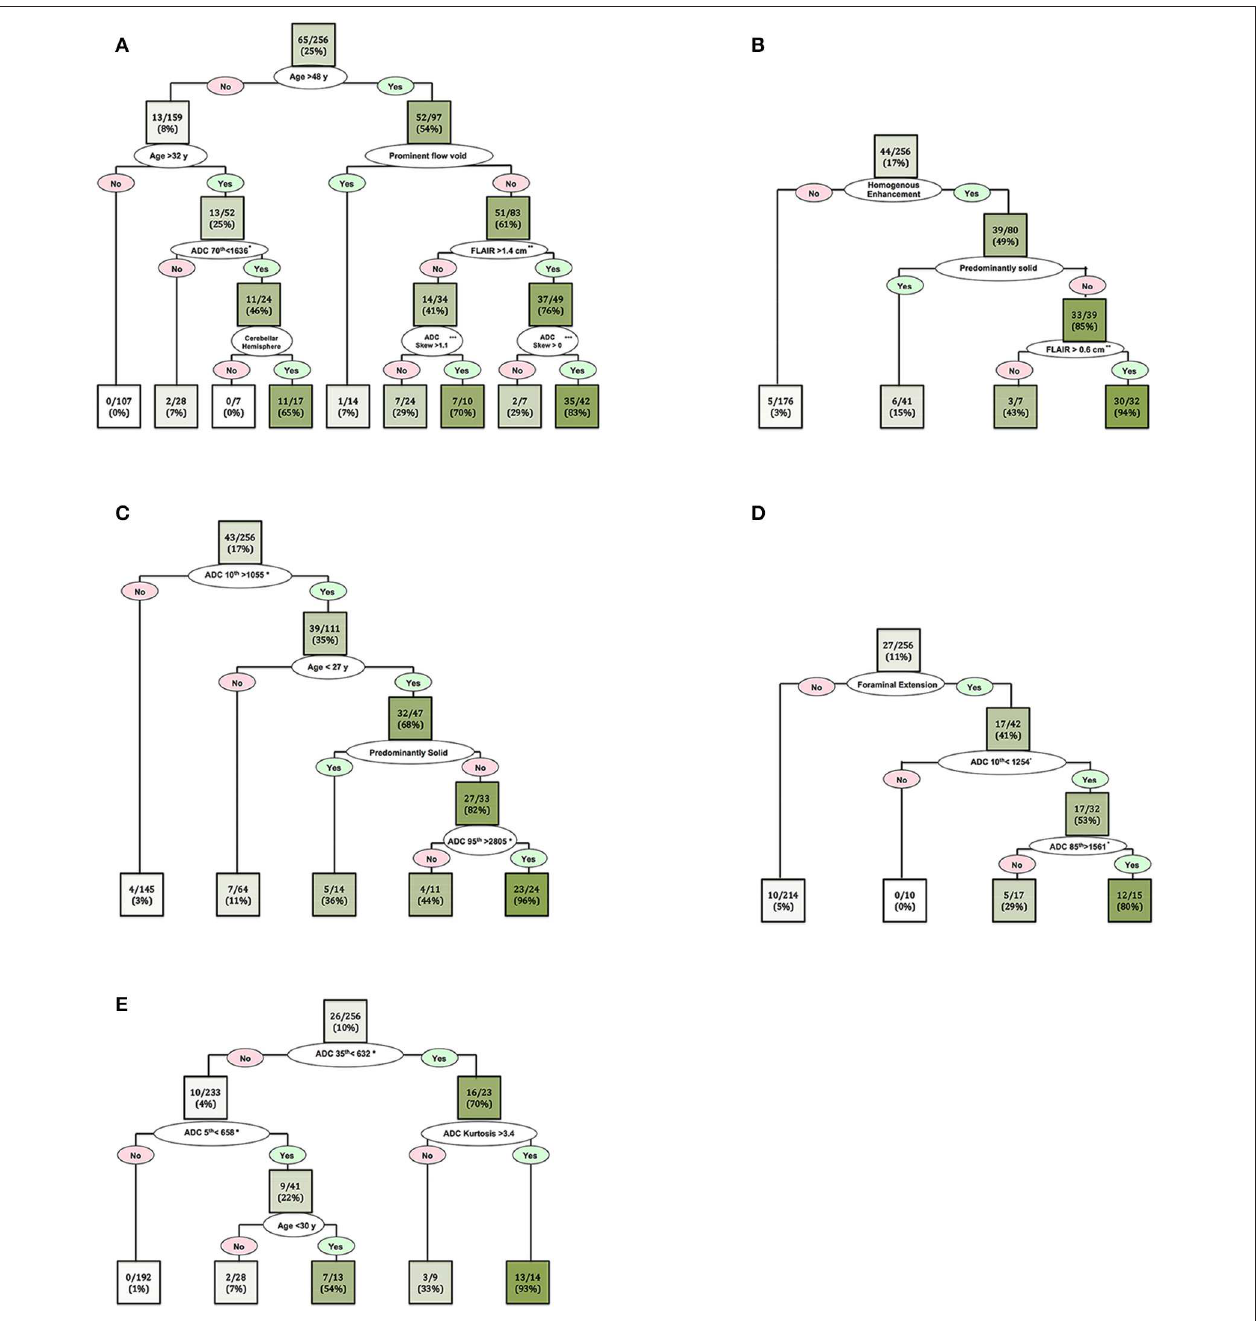
FIGURE 6 | Decision tree models for dichotomized differentiation of the 5 most common posterior cranial fossa neoplasms: (A) metastasis, (B) hemangioblastomas, (C) pilocytic astrocytoma, (D) ependymomas, and (E) medulloblastomas. In each box (node/leaf), the accurate classification rate (positive predictive value) is expressed as ratios of the most common tumor type per total number of cases fulfilling the criteria. The intensity of the green color reflects the accurate classification ratio. Froaminal extension refers to tumoral extension through the foramina of Luschka and/or Magendie. *The ADC n th refers to the ADC histogram n th percentile value × 10 − 6 mm 2 /s; for example, ADC 70th percentile < 1,636 × 10 − 6 mm 2 /s. **Peritumoral FLAIR hyperintensity width. ***ADC histogram skewness.